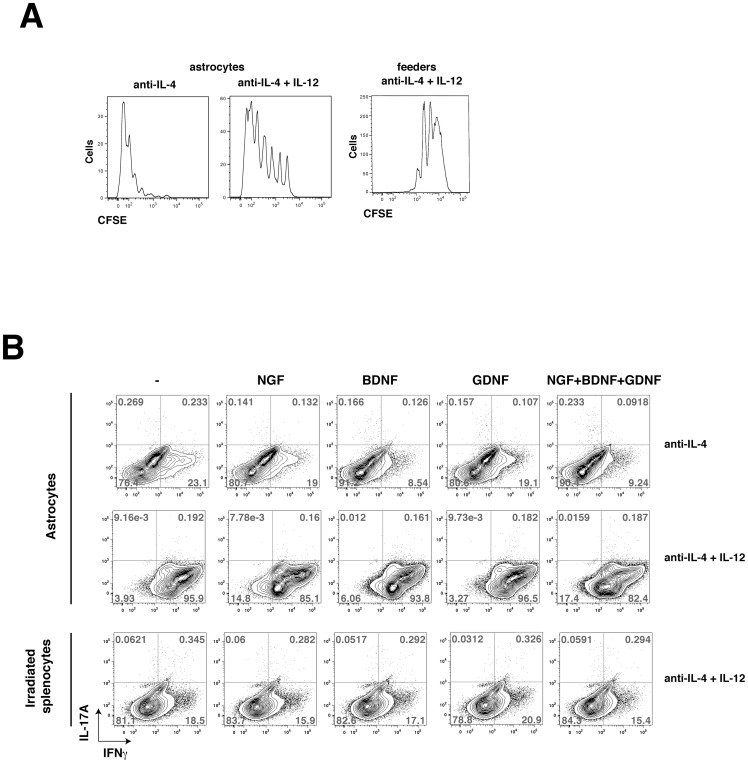
Th1 differentiation is not dependent on GDNF, BDNF or NGF.(A) CD4+ T cells were polarized toward Th1 cells for 3 days cultured on astrocytes or with irradiated feeder cells in medium supplemented with 10 ng/mL IL-12 (Th1). Cells were washed and stimulated for 4 hr with PMA/ionomycin and CD4+ T cells were analyzed for CFSE staining by flow cytometry gated on IFNγ+CD4+ T cells. Data are representative of 2 independent experiments. The rate of cell division was higher in cells incubated in Th1-polarizing conditions than undifferentiated cells. (B) CD4+ T cells cultivated on astrocytes or irradiated splenocytes were stimulated with 10 ng/mL GDNF, 10 ng/mL BDNF, 100 ng/mL NGF, or a combination as indicated, in the presence or not of Th1 polarizing conditions for 4 days. Cells were washed and stimulated with PMA/ionomycin/BFA for 4 h and IFNγ-producing cells were analyzed by flow cytometry. Plots are representative of 2 independent experiments.